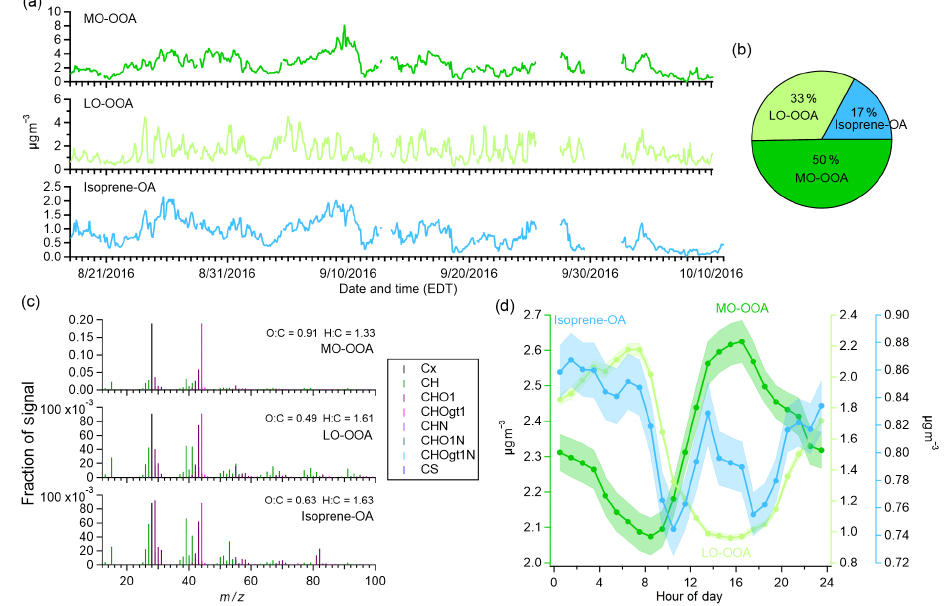
Figure 3. (a) Time series and study mean (b) mass fraction, (c) normalized mass spectra, and (d) diurnal profiles (standard deviations in shaded areas) of AMS OA factors resolved by